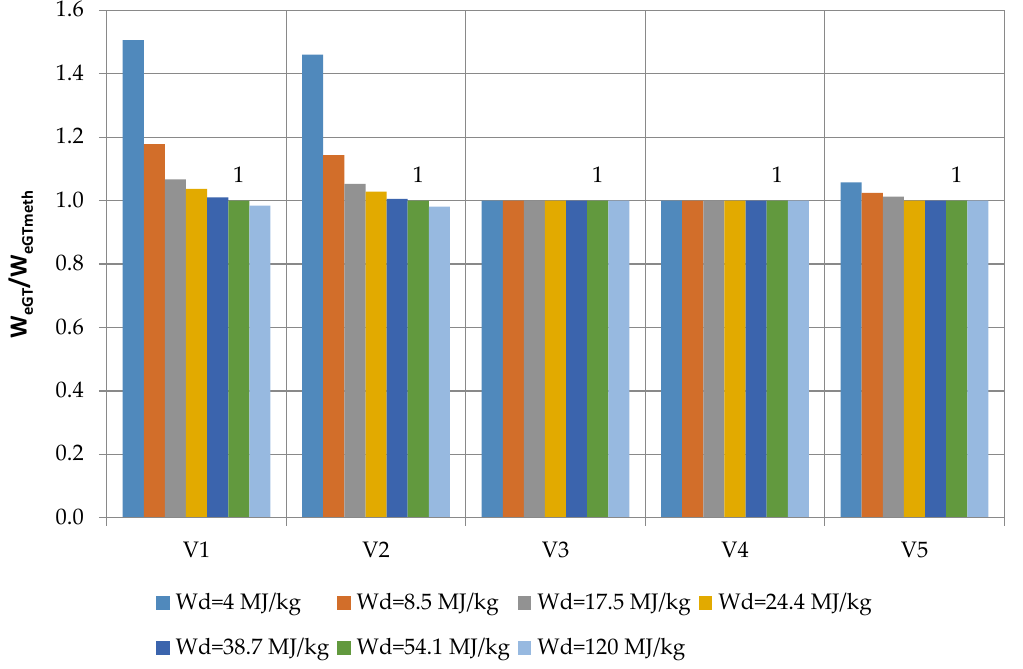
Figure 15. Collective diagram of the effect of the structure of cycle and calorific value of fuel on the effective power in relation to the variants of the cycle with methane as a fuel.